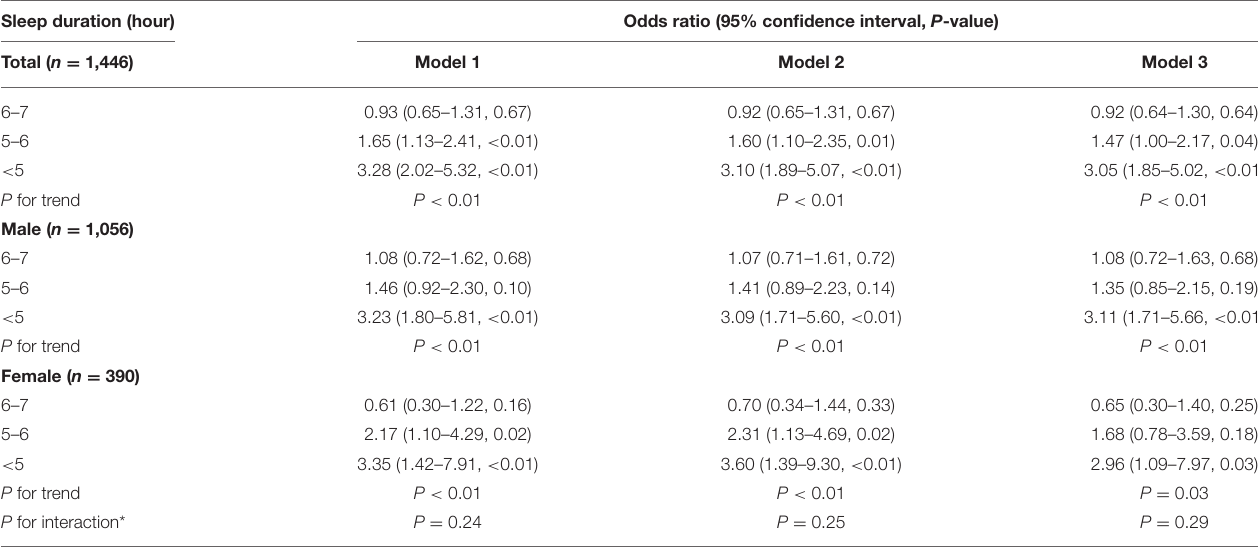
TABLE 3 | Impact of sleep duration on depression at 3 months after